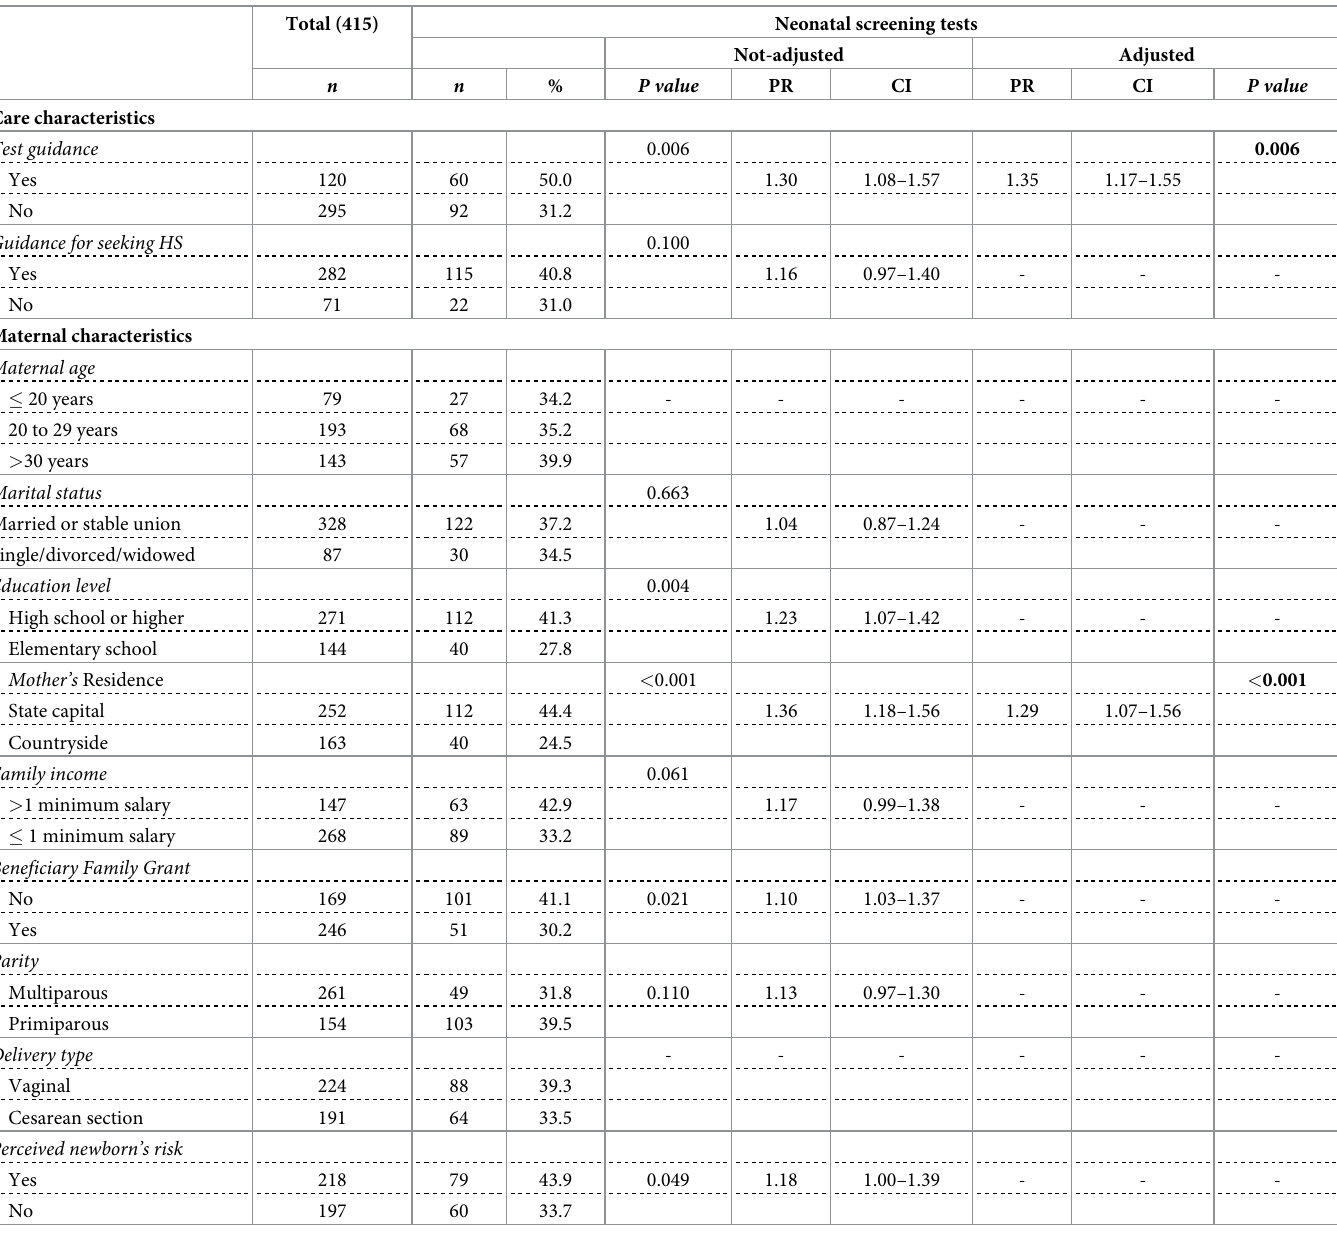
Table 2. Association of care and maternal characteristics with the completion of the five NS tests Natal/Brazil, 2019 (n = 152). Total